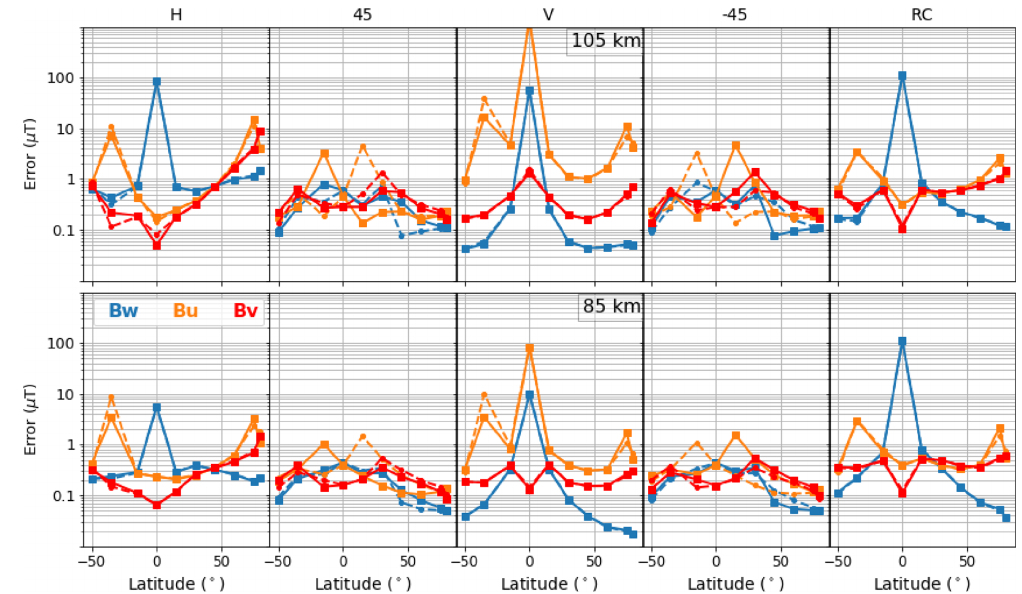
Figure 11. Same as Fig. 9 but for the geomagnetic field components and altitudes between 85 and 105km. The retrieval vertical resolution is